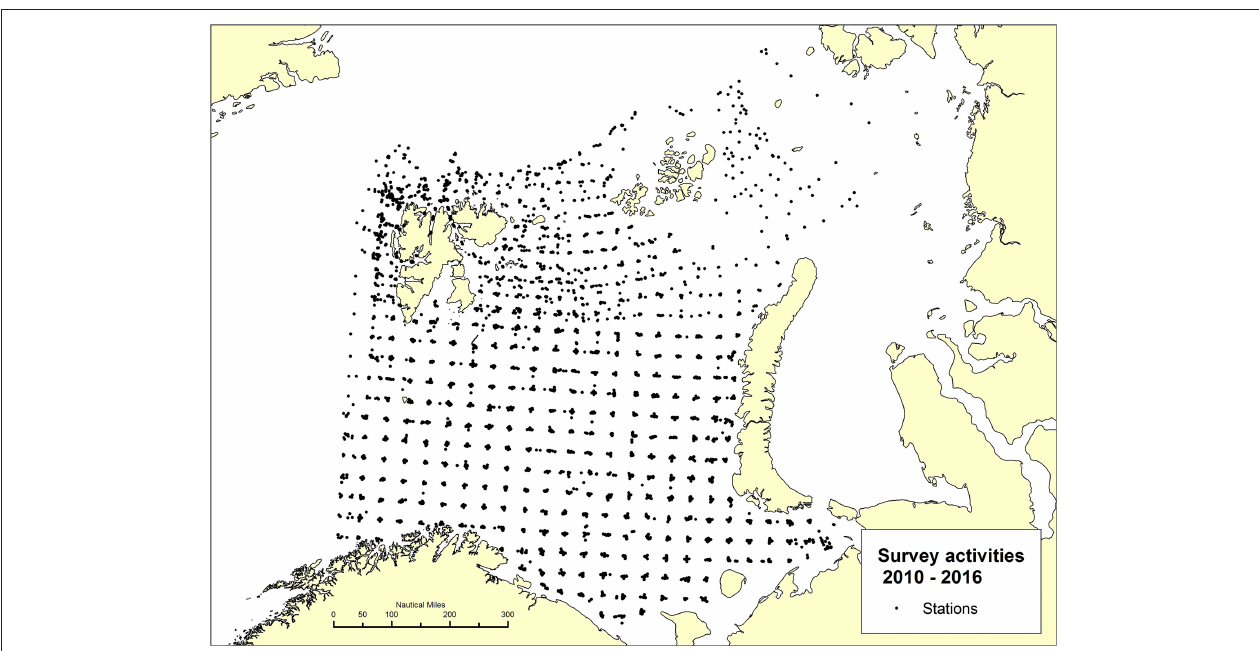
FIGURE 2 | Survey activities 2010–2016. The BESS covers the entire Barents Sea with 35 nautical miles between ecosystem stations. Dots indicate stations, where pelagic and bottom trawl hauls were taken. Location of station varied slightly between years.